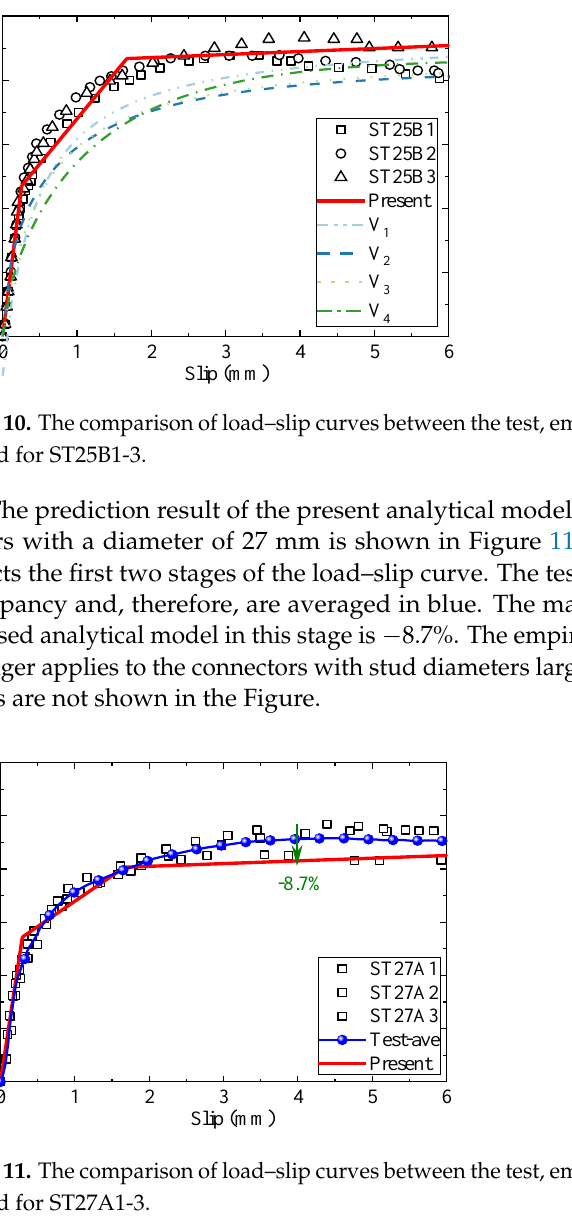
Figure 9. The comparison of load–slip curves between the test, empirical formulae, and the analytical method for ST25A1/2.